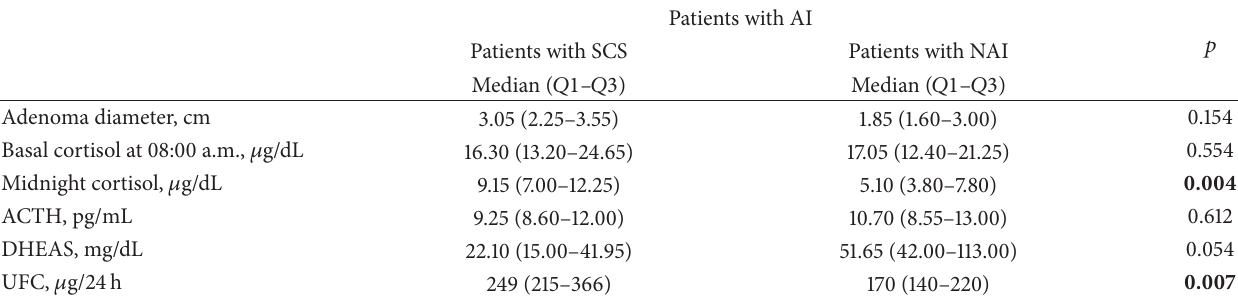
Table 2: Hormonal profiles and adenoma diameters of the patients with adrenal incidentaloma. Patients with